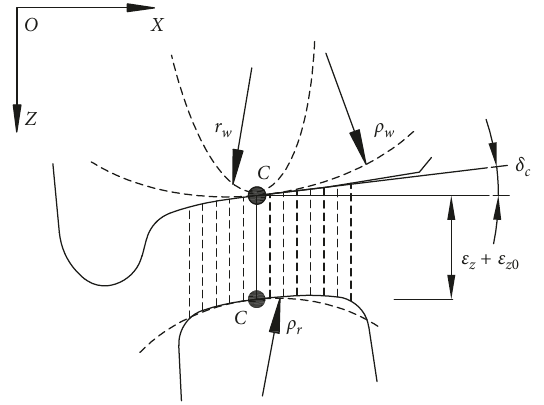
Figure 9: Geometric wheel-rail contact model. Table 1: Fitting parameters of the F 1 ( e ) and F 2 ( e )